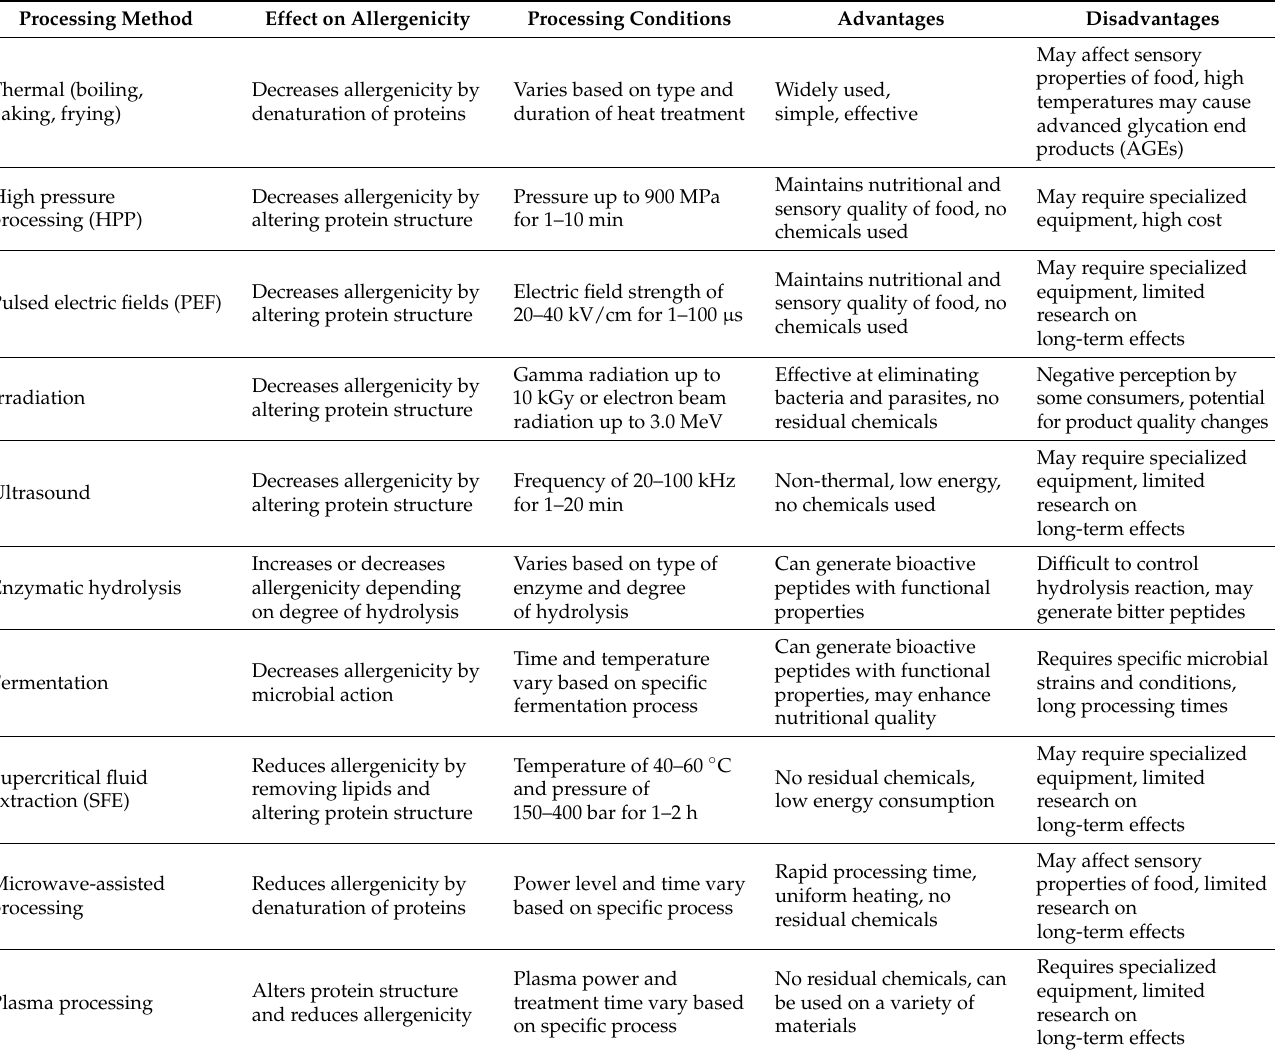
Table 3. Effect of processing on the allergenicity of egg